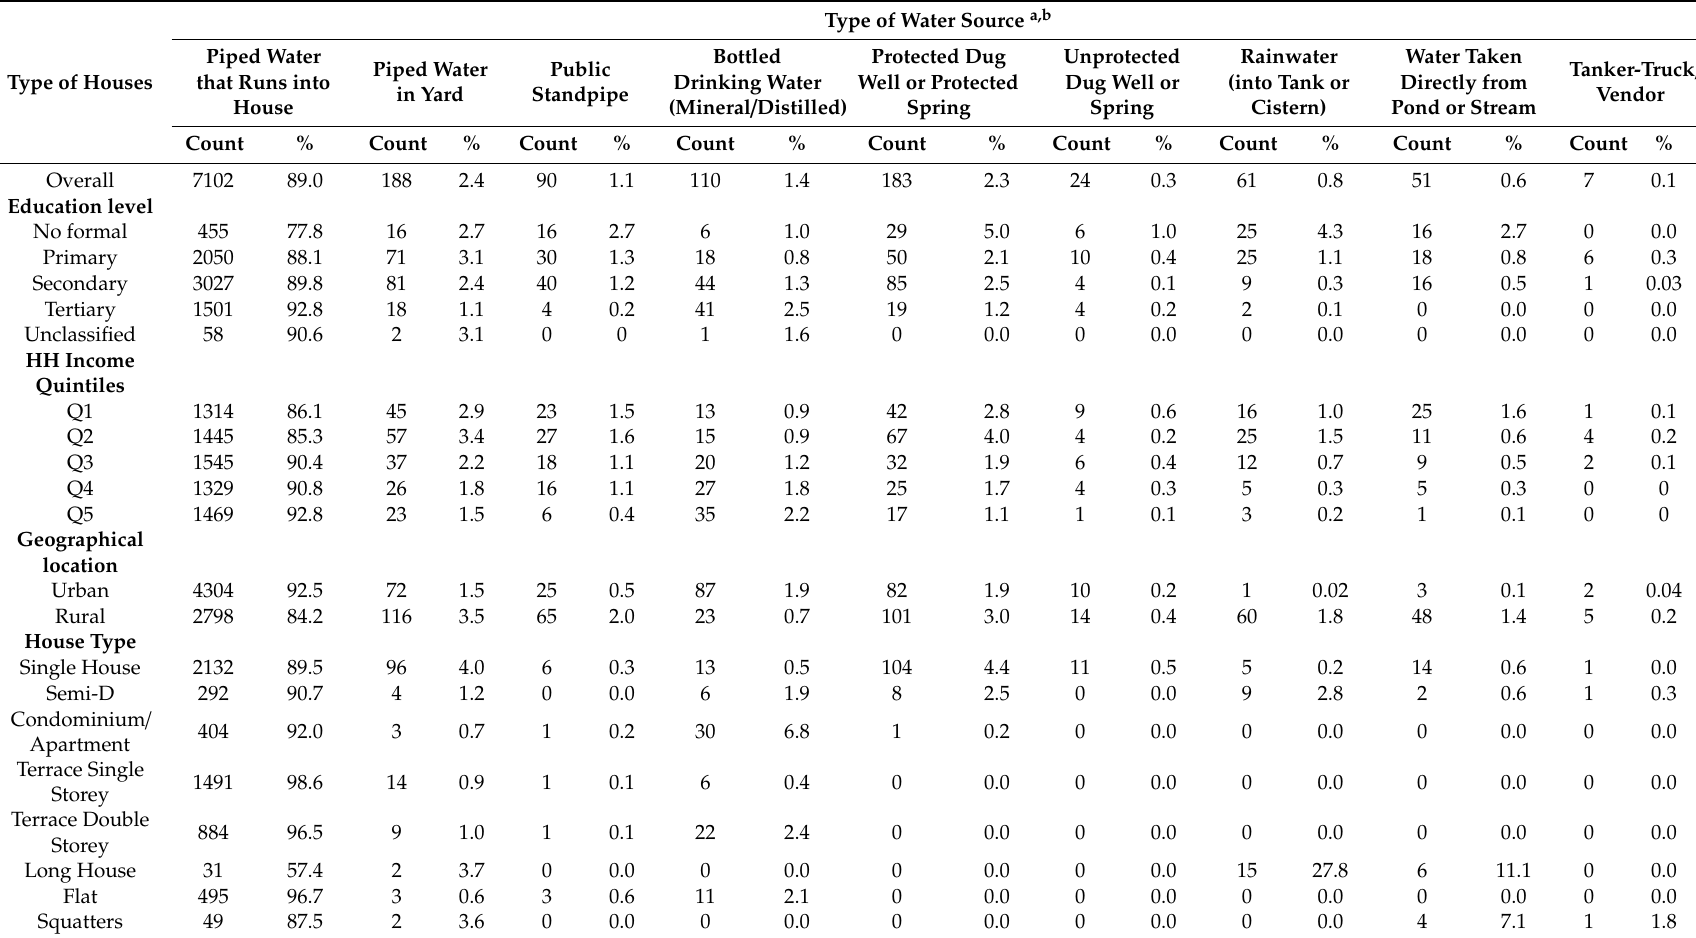
Table A1. Relationships between socio-economic factors and type of water source used by